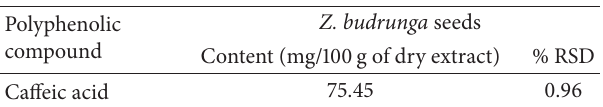
Table 3: Contents of polyphenolic compounds in Z. budrunga seed extract ( 𝑛 = 5 ).